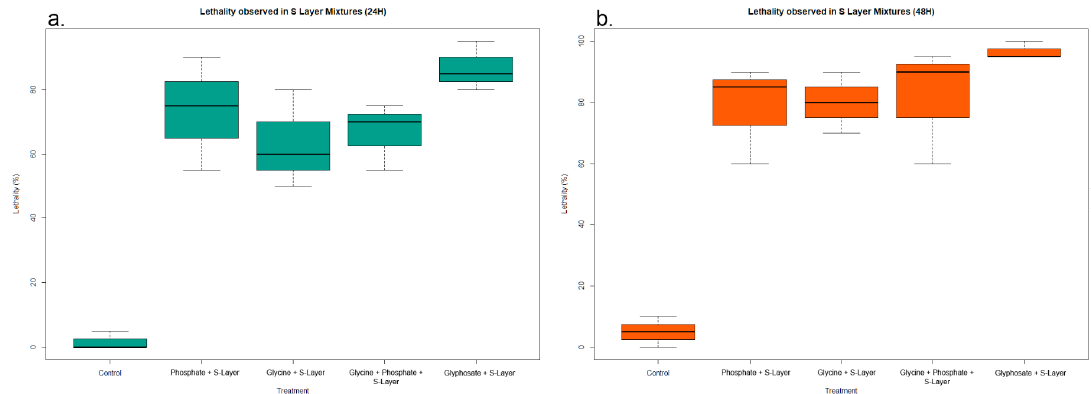
Figure 3. Lethality responses observed in the Ae. albopictus larvae after exposure to mixture of the treatment solutions and S-Layer concentrations at ( a ) 24 h of exposure and ( b ) 48 h of